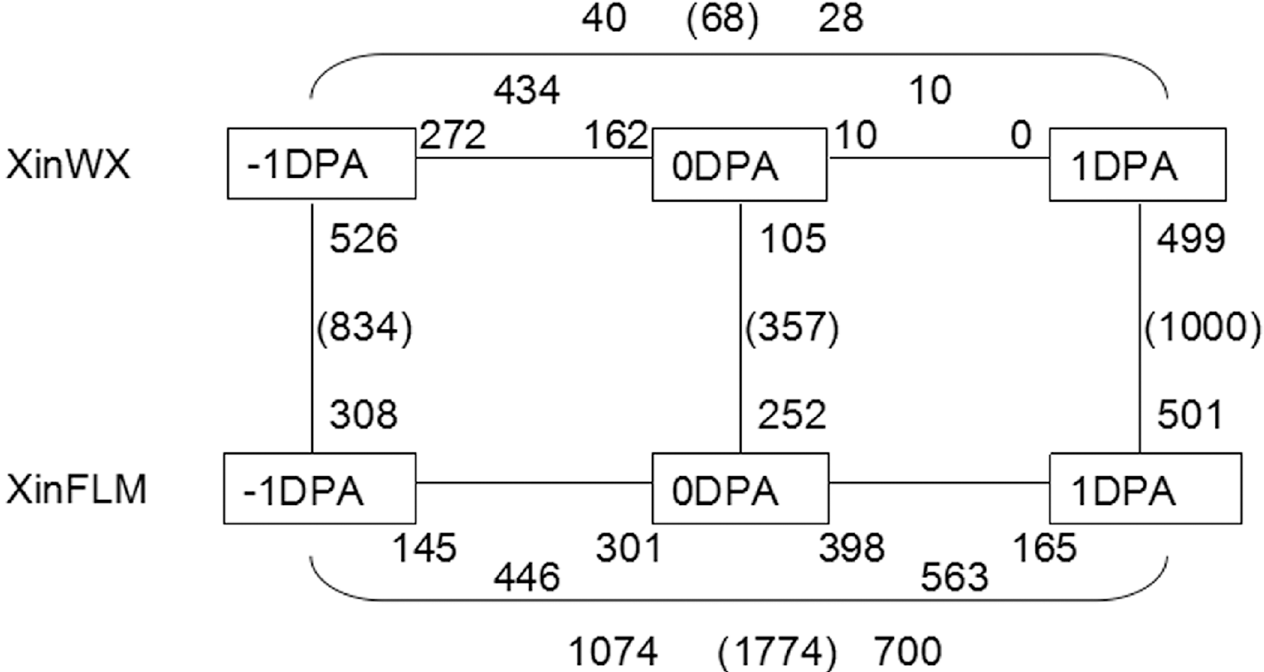
Fig 2. Number of differentially expressed genes within and between XinWX and XinFLM. Microarray analysis was performed on three replicates of each sample at three stages (represented by boxes) for both accessions. Numbers on or beside the line designate the number of upregulated genes ( > 2-fold, FDR < 0.05) relative to the adjacent developmental stage or between two accessions. The total number of genes in each comparison is given in